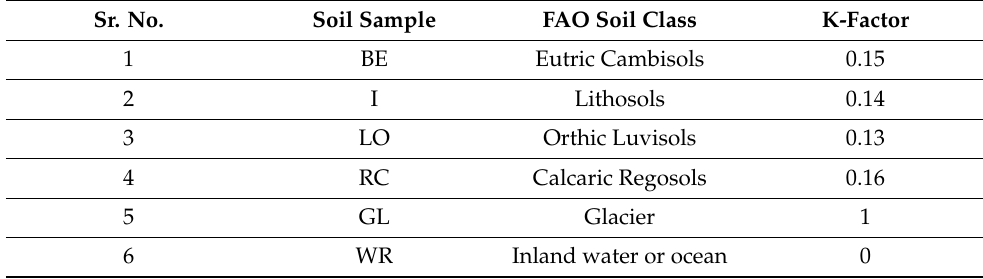
Table 2. K-factor values for different soil types of the study area. Sr.